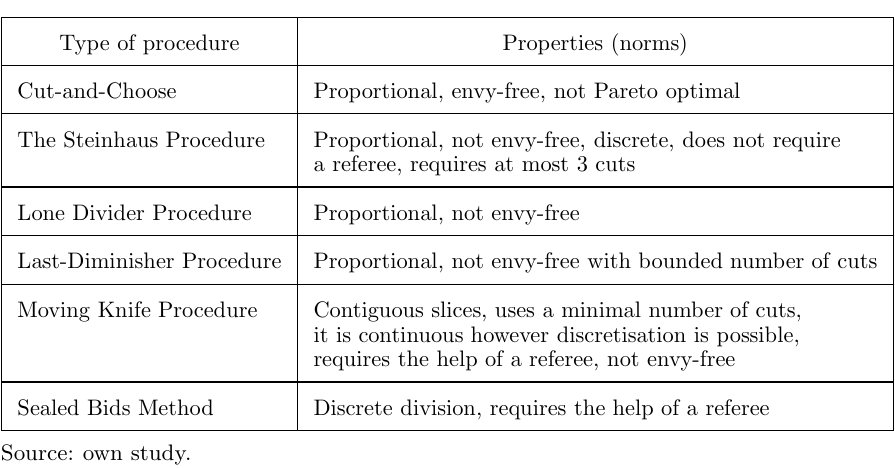
Table 1 Comparison of properties some fair division